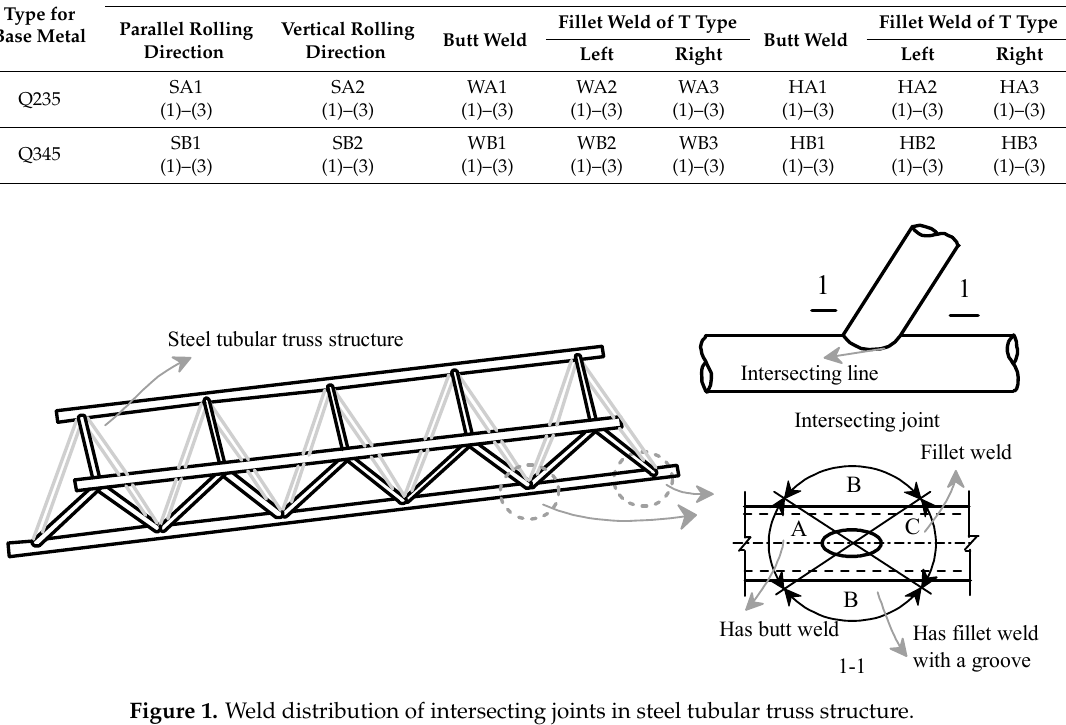
Figure1. Weld distribution of intersecting joints in steel tubular truss structure. Figure 1. Weld distribution of intersecting joints in steel tubular truss